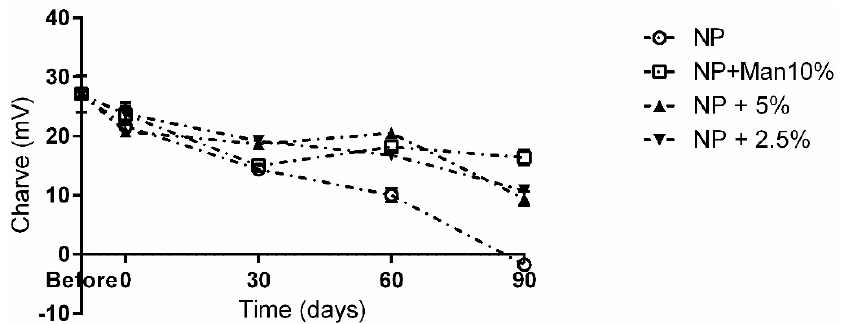
Figure 4. Long term storage impact on NP charge in the presence and absence of mannitol. ⊚ —NPs without cryoprotectant; (cid:31) —NPs with 10% ( w / v ) mannitol; ▲ —NPs with 5% ( w / v ) mannitol; ▼ —NPs with 2.5% ( w / v ) mannitol.